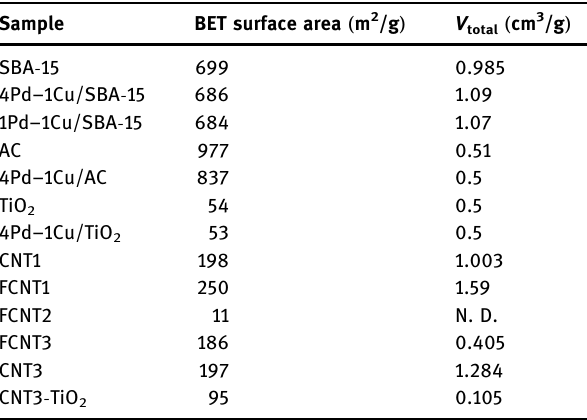
Table 2: BET properties of the used catalysts Sample BET surface area ( m 2 /g )